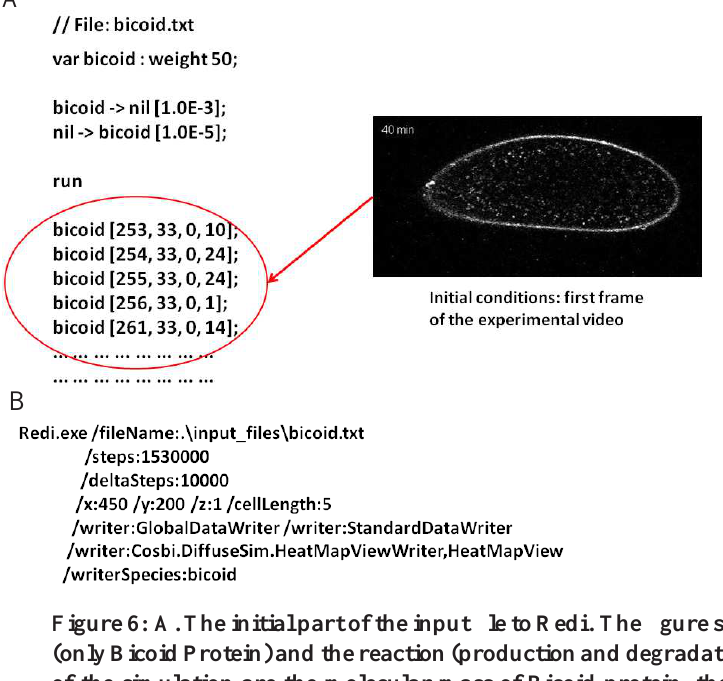
Figure 6: A. The initial part of the input file to Redi. The figure shows the declaration of the species (o nly Bicoid Protein) and the reaction (production and degradation of the protein); the parameters of the simulation are the molecular mass of Bicoid protein, the rate constants of the production and degradation reactions. The initial conditions are specified in a sort of ”matrix-like” syntax. B. The command line launched to run the Redi